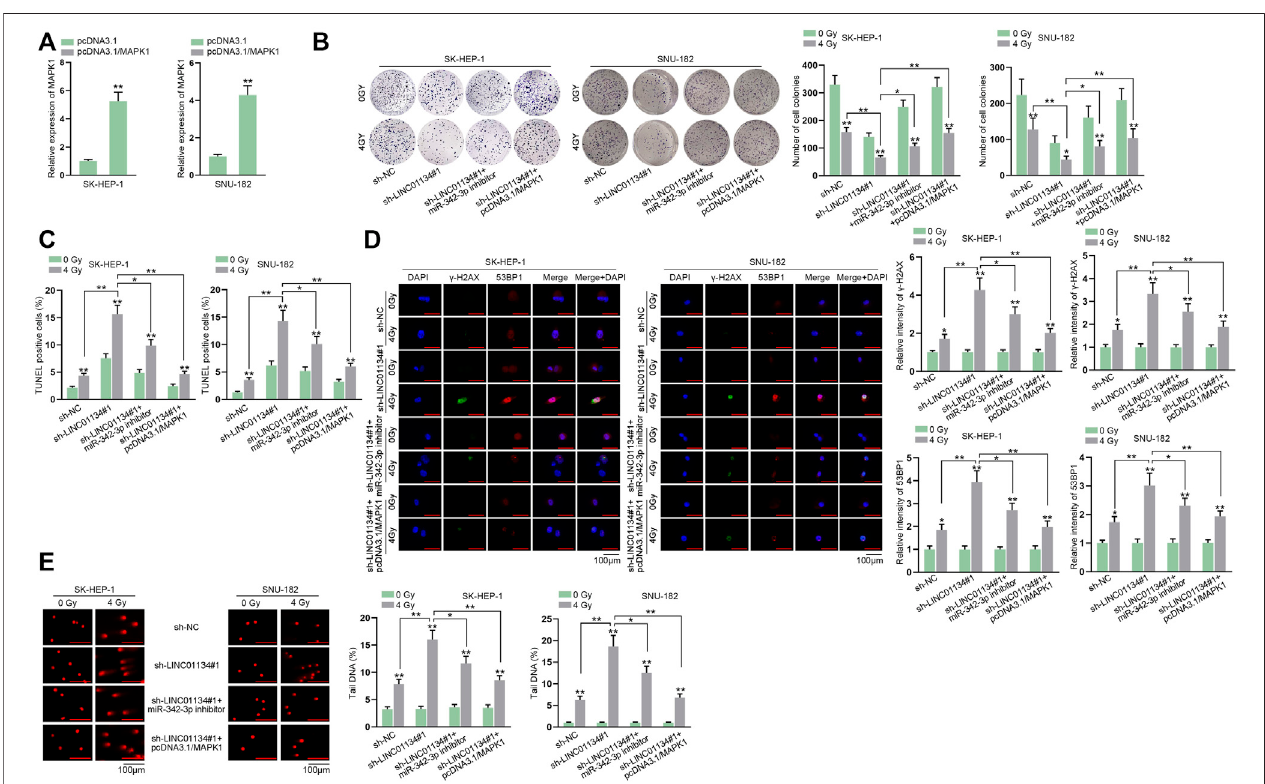
FIGURE 7 | LINC01134 participates in the regulation of radioresistance of HCC cells by enhancing MAPK1 expression. (A) The overexpression ef fi cacy of pcDNA3.1-MAPK1wastestedbyRT-qPCRinHCCcells.HCCcellsweretransfectedwithdifferentplasmids:sh-NC,sh-LINC01134#1,sh-LINC01134#1+miR-342-3p inhibitor,andsh-LINC01134#1+pcDNA3.1/MAPK1. (B,C) CellproliferationandcellapoptosiswereobservedbycolonyformationandTUNELassays. (D) Theformation of γ -H2AX and 53BP1 foci was assessed in HCC cells respectively transfected with indicated plasmids (magni fi cation: 100 × ). (E) Comet assay was performed to evaluate DNA repair under different conditions. * p < 0.05, ** p <